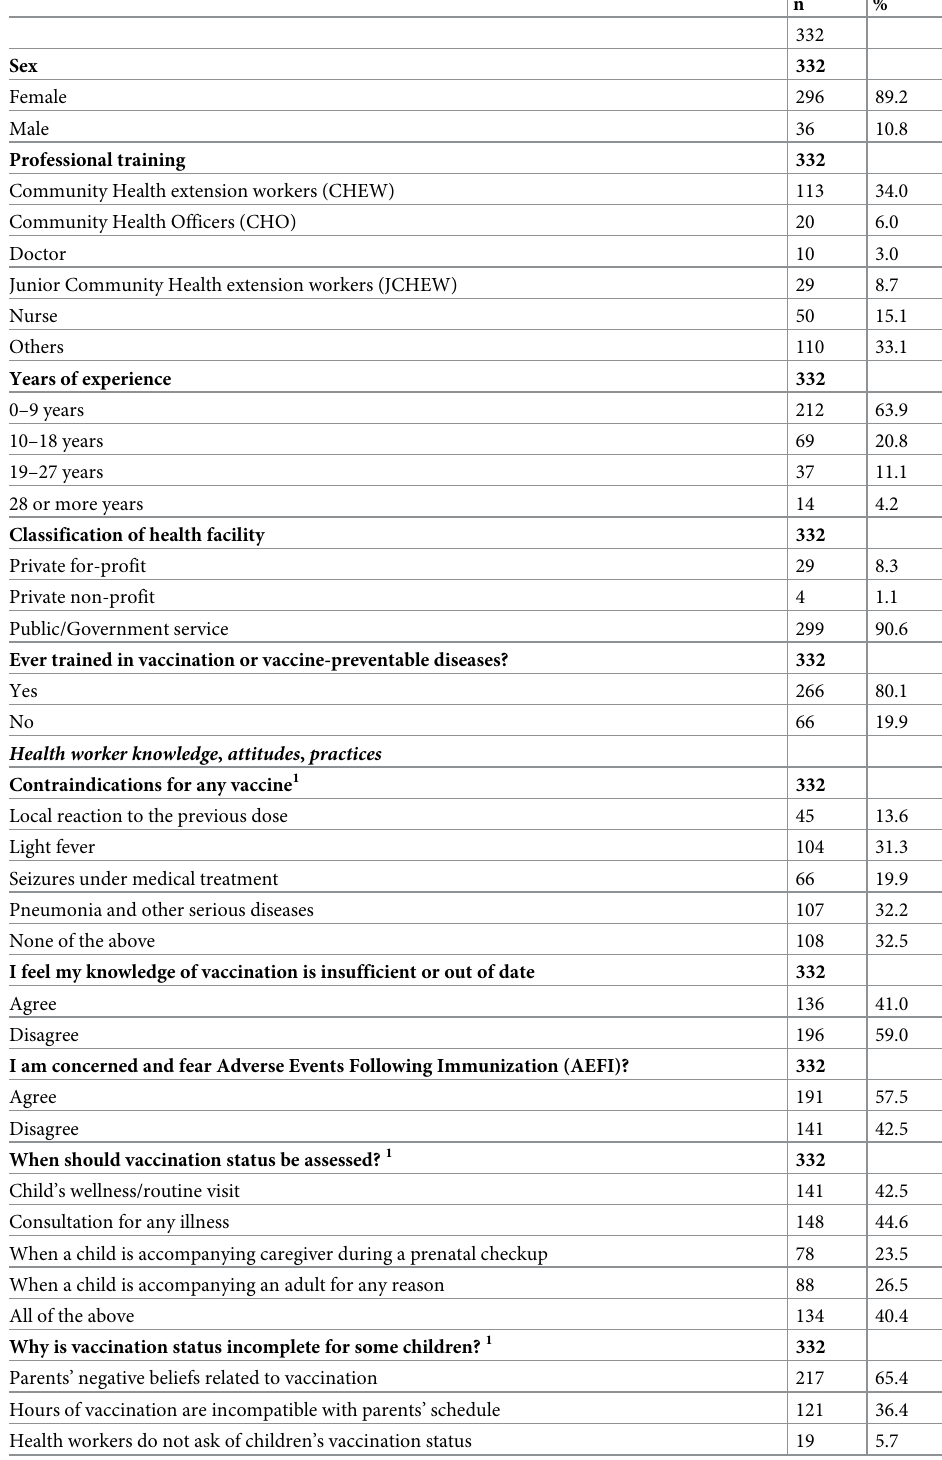
Table 6. Characteristics and knowledge, attitudes, and practices of health workers surveyed during a Missed Opportunities for Vaccination (MOV) assessment, Ondo State, Nigeria, 2019.